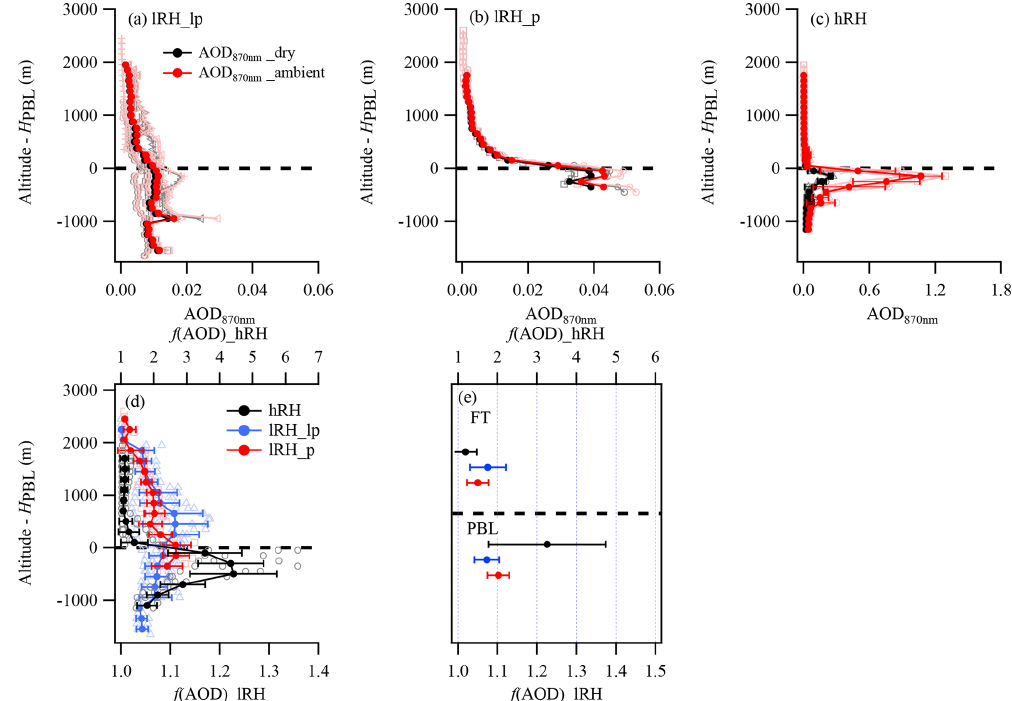
Figure 6. Vertical profiles of AOD under lRH and hRH conditions; (a) low RH and less polluted condition (lRH_lp), (b) low RH and polluted condition (lRH_p), and (c) high RH condition (hRH). The gray and light red lines indicate the AOD for dry and ambient RH conditions, respectively; (c–d) vertical profiles of f (AOD) (the ratio of calculated ambient AOD and dry AOD) and corresponding mean ± σ in the FT and PBL. Note that the f (AOD) for hRH uses the top x axis.